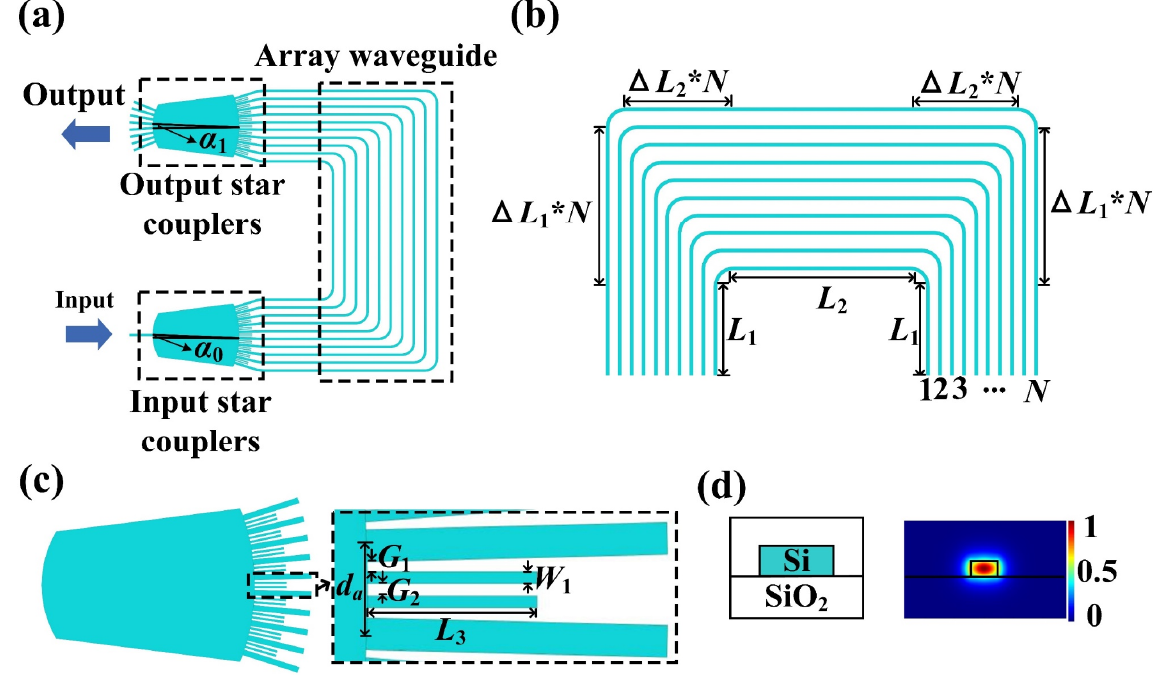
Figure 1. ( a ) Schematic of the nanowire-assisted AWG structure with ( b ) and ( c ) for the magnified view of arrayed waveguides and star coupler, respectively. ( d ) Waveguide platform and fundamental TE mode.